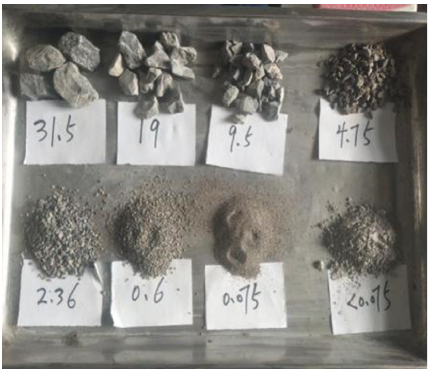
Figure 4: Sifted aggregate of crushed